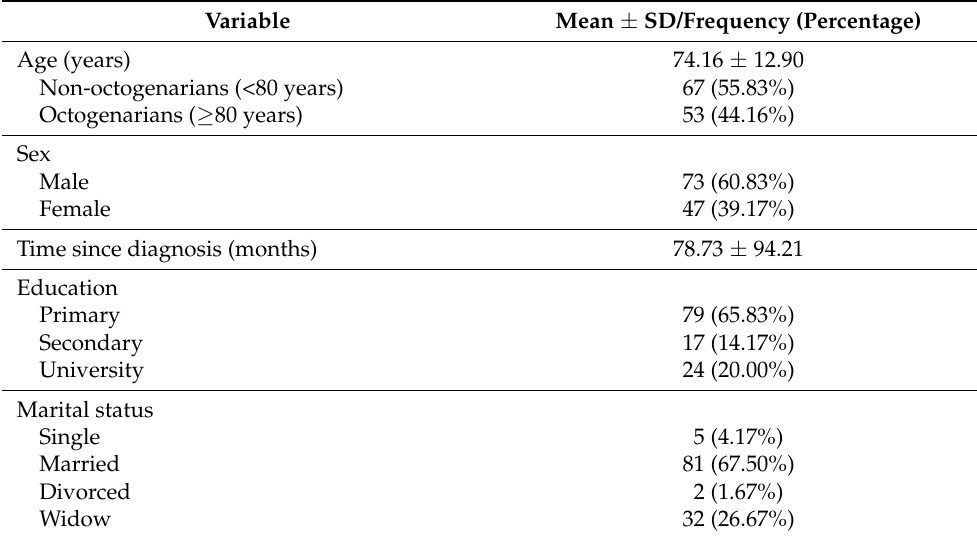
Table 2. Sociodemographic characteristics of the sample.